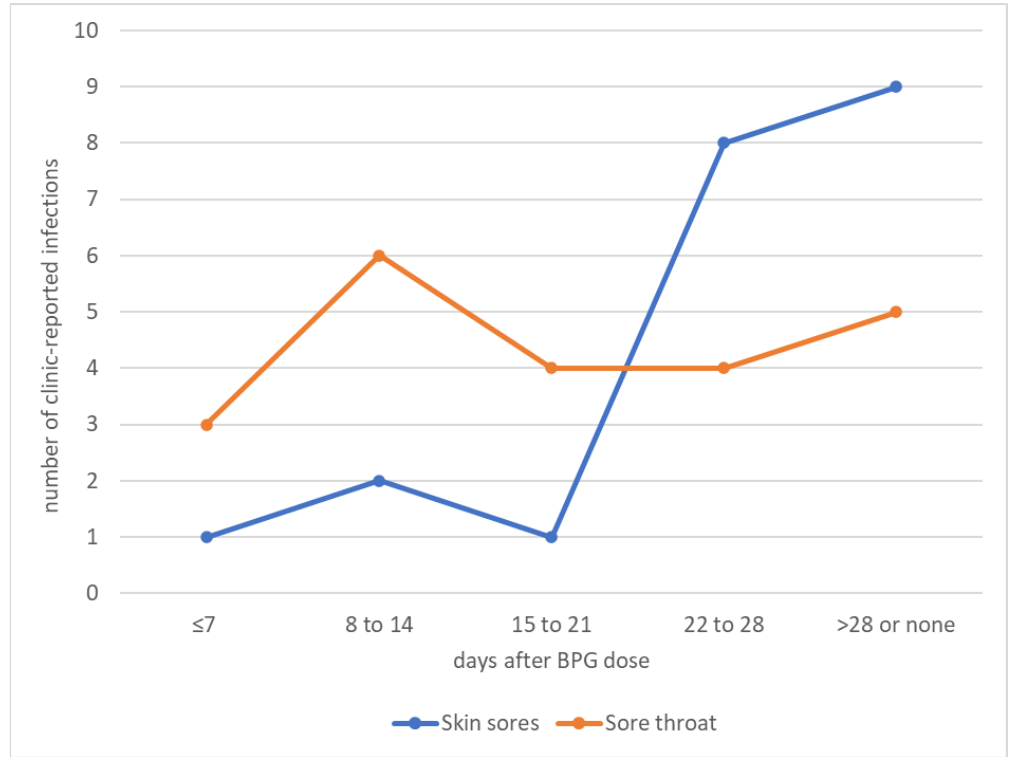
Figure 5. Numbers of potential streptococcal infections by time since last benzathine benzylpenicillin dose.